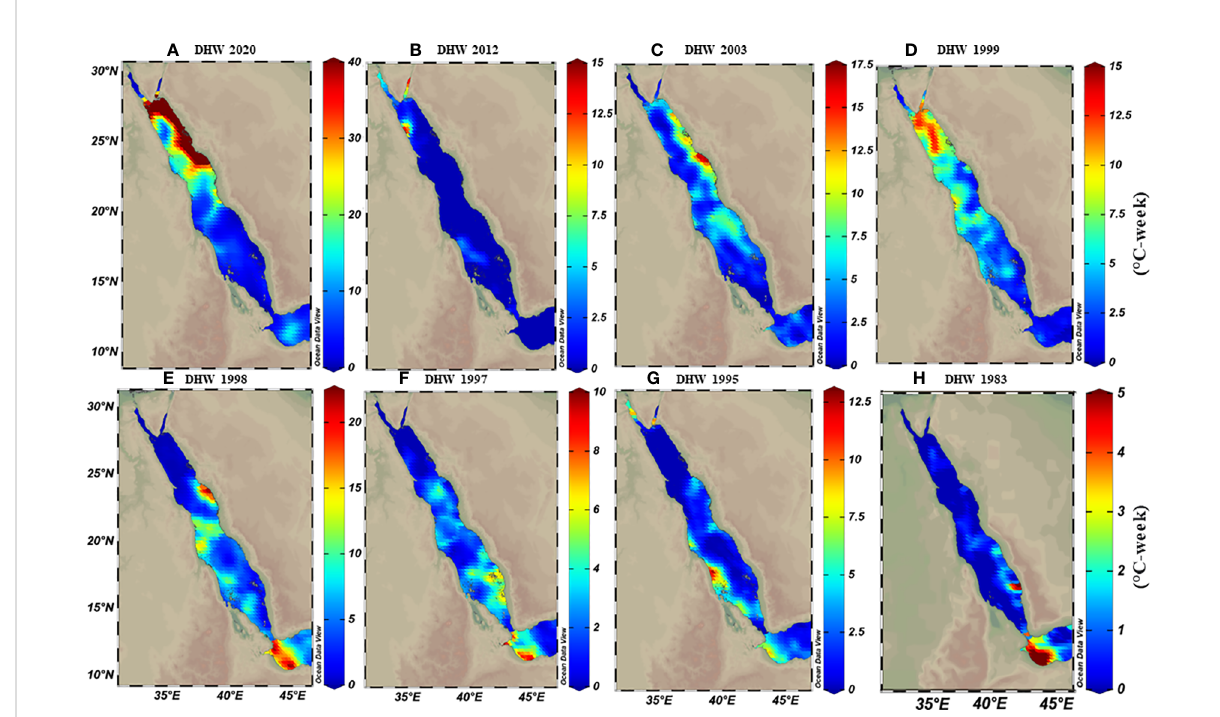
FIGURE 3 Calculated maximum degree heating weeks (DHWs) based on MMM+1°C for representative years over the 39 years data analysis period (1982- 2020). Maps demonstrate how DHWs shifted from the southern (in E-H ) to the northern region (A-D) over time, where DHWs were restricted to the southern regions until the 2000s. In contrast, the frequency and intensity of DHWs shifted toward the northern regions. Notably, the colour legend in each map has a different scale range to exemplify the increase of DHWs intensity over time along the Red